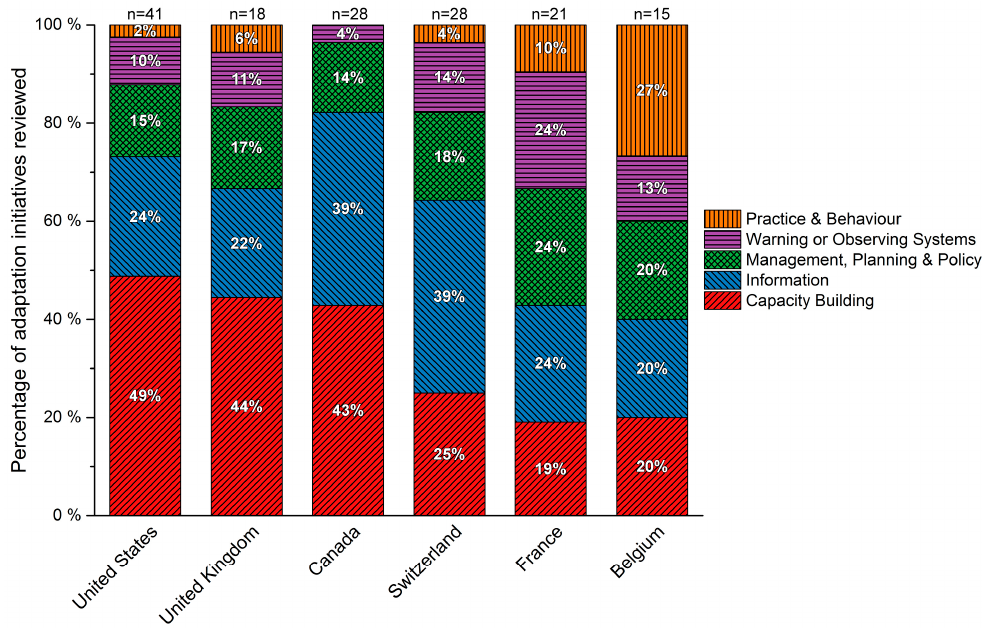
Figure 3. Percentage of adaptation type by sub-sampled country. Countries with less than